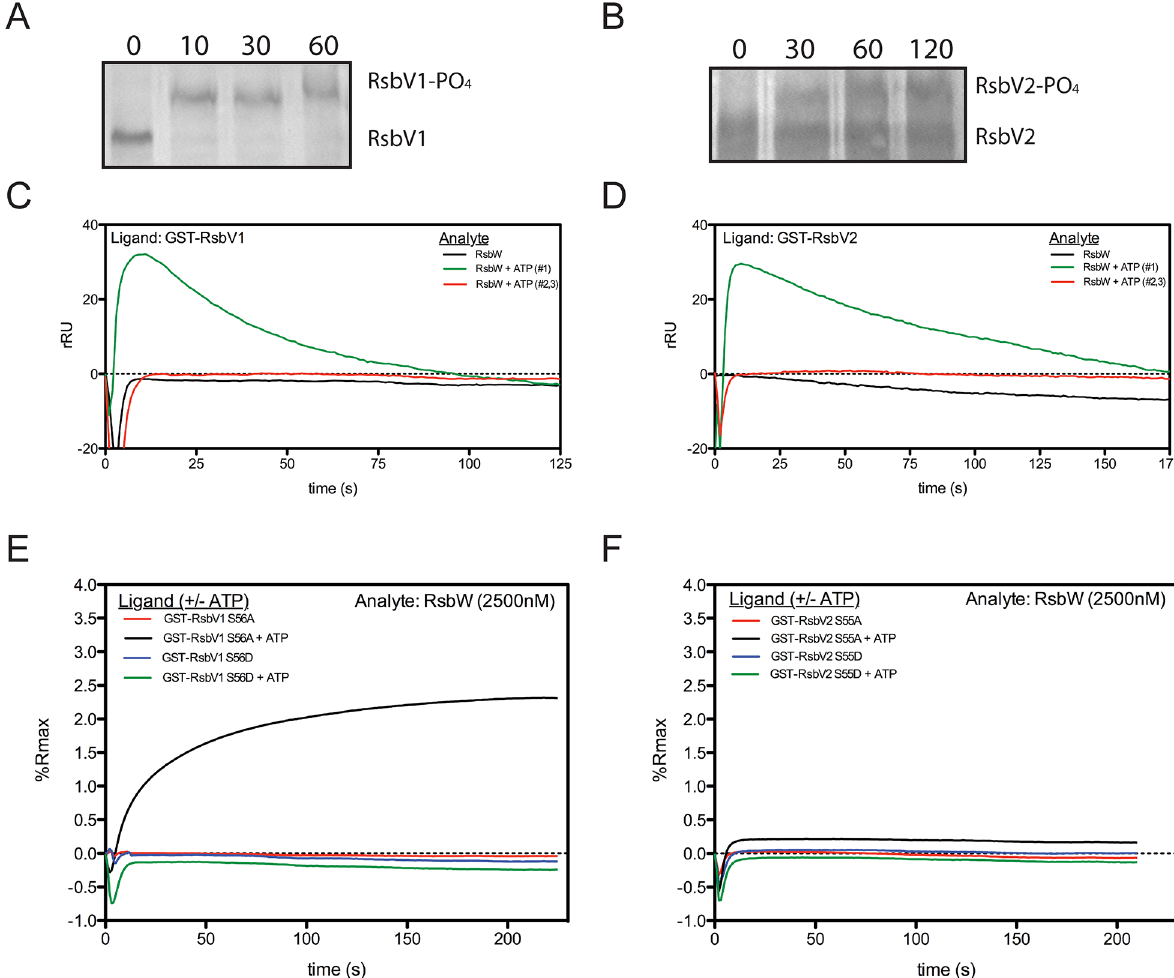
Fig 2. Association of RsbW- Ct with antagonist depends on ATP and the phosphorylation state of the antagonist. Purified RsbV1 (A) and RsbV2 (B) were incubated in the presence of RsbW Ct + ATP and monitored longitudinally (minutes) for phosphorylation, detected via electromobility shift during Phos- tag supplemented gel electrophoresis. Each panel represents two experiments in which the same results were obtained. For SPR analysis, antagonists RsbV1 (C) and RsbV2 (D) were immobilized and charged with 2500nM RsbW Ct- in the absence (black) or presence (first attempt, green; repeated attempts, red) of ATP. Response over time was normalized by the response in an empty flow-cell. Sensorgrams shown represent two experiments (separate sensorchips) in which the same trends were observed. Derivative mutants, in which the phospho-accepting residues were changed to aspartic acid (S56D, S55D) or alanine (S56A, S55A) for RsbV1 (E) and RsbV2 (F), respectively, were tested for their ability to associate with RsbW Ct . Serine to aspartic acid mutations, mimicking a permanently phosphorylated state, prevented the association of RsbW Ct in both the absence (blue) and presence (green) of ATP